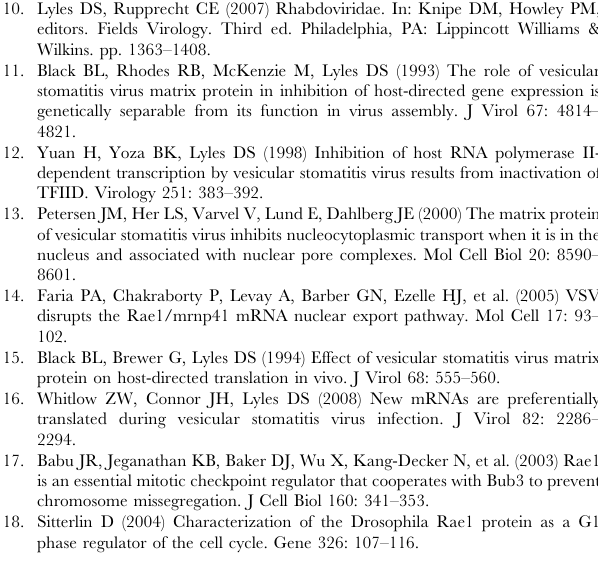
Table S1 Effects of silencing the expression of Rae1 on mRNA expression in VSV-infected cells. HeLa cells were transfected with Rae1 siRNA or NT siRNA, then mock-infected or infected with rwt virus. At 6 h postinfection, total RNA was isolated and analyzed using Affymetrix Human Genome U219 Array strips. Data shown are probe sets that were reproducibly decreased ( A and B ) or increased ( C and D ) by greater than 3-fold (log 2 3= 1.58) in VSV-infected versus mock-infected siNT cells ( A and C ) or siRae1 cells ( B and D ). The selection criteria were that the pooled variance in the probe set in repeat experiments gave p , 0.005 in comparing VSV-infected to mock-infected cells. In siNT cells, 880 probe sets met this criterion, of which 17 were decreased . 3-fold ( A ) and 12 were increased . 3-fold ( C ). In siRae1 cells, 970 probe sets met this criterion, of which 5 were decreased . 3-fold ( B ) and 41 were increased . 3-fold ( D ). The selection of a 3-fold difference as a criterion for this table was based on a comparison of mock-infected siRae1 versus siNT cells. In this comparison, 713 probe sets had p , 0.005. Of these only 3 were decreased . 3-fold ( E ), including Rae1